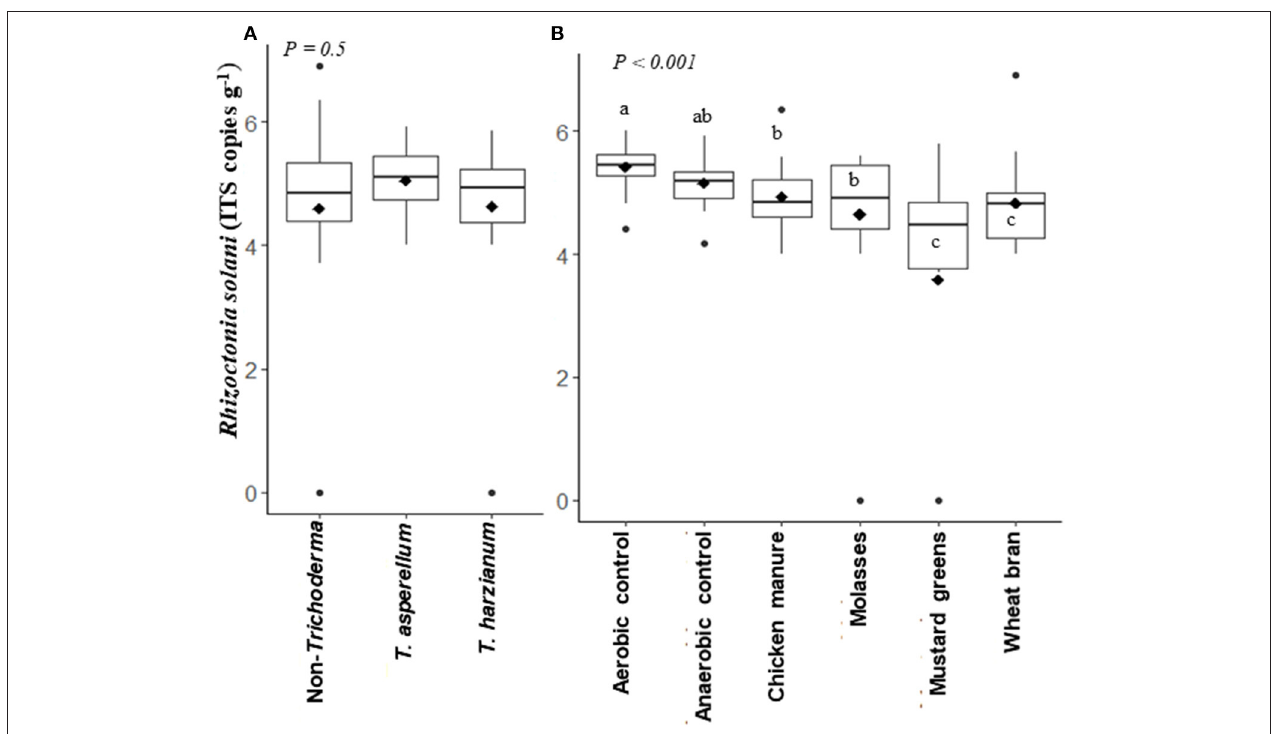
FIGURE 5 | Rhizoctonia solani populations (log ITS copy number g − 1 soil) in soils affected by Trichoderma isolate inoculation (main plot) (A) and anaerobic soil disinfestation (ASD) carbon sources (subplots) (B) presented in box plots; black lines indicate median, black diamonds indicate mean values and black dots are outliers, P -value is the analysis of variance probability value after 1 + log transformation, CFU indicates colony forming unit means followed by same letter(s) do not differ significantly at 5% level of probability. Data presented are from two combined independent experiments each with three